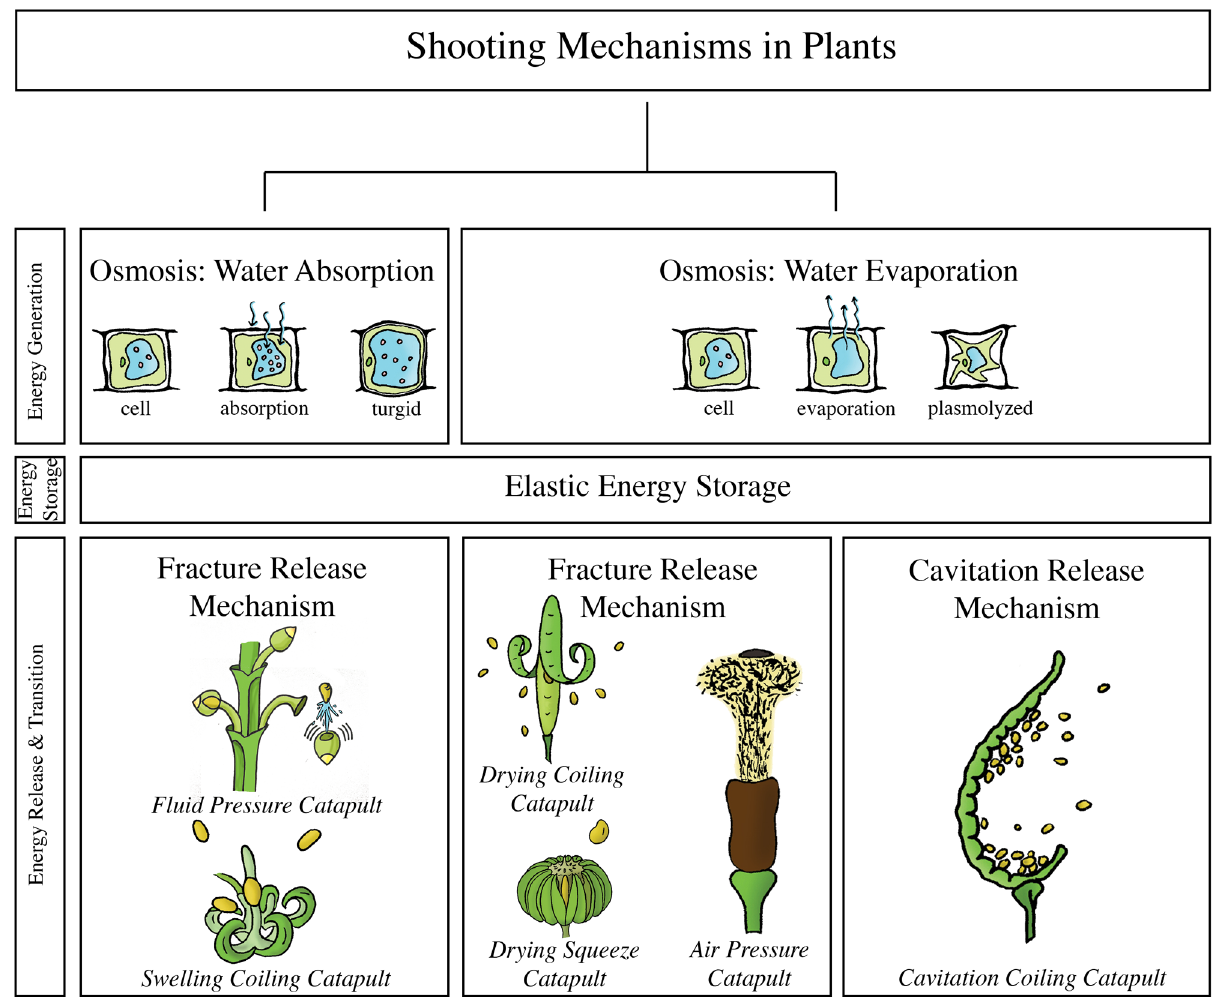
Fig 9. The structural categorization of the identified shooting mechanisms in plants, allocated based on the energy management criteria discussed above. Fluid pressure catapult : observed in the genus Arceuthobium . Swelling coiling catapult : observed in the genus Impatiens , Cornus canadensis , and Morus alba , schematic illustration of Impatiens capensis , Drying coiling catapult : observed in the genus Cardamine and the family Fabaceae, schematic illustration of Cardamine parviflora . Drying squeeze catapult : observed in the family Euphorbiaceae, the Rutaceae family, the genus Illicium , the species Oxalis acetosella , and the Viola family, schematic illustration of Hura crepitans . Air pressure catapult : observed in the genus Sphagnum . Cavitation coiling catapult : observed in the family Polypdiaceae and genus Selaginella , schematic illustration of Polypodium aureum . In contrast to the situation in fungi, no shooting mechanisms were identified in the water condensation